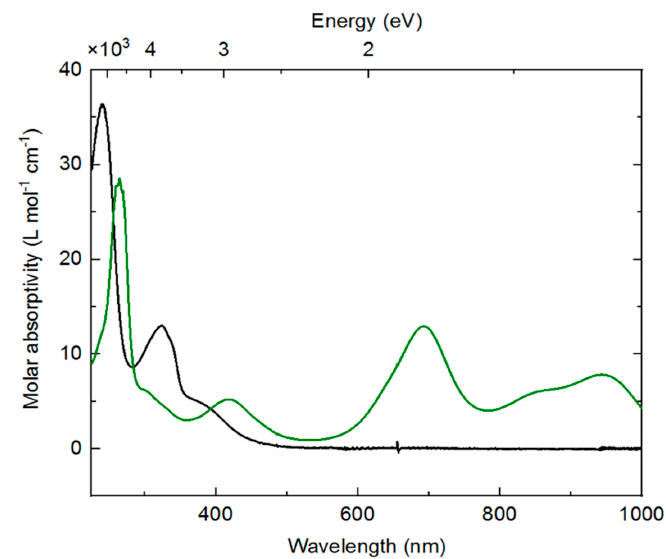
Figure 4. Electronic absorption spectra of 3 (black line) and 4 (green line). Conditions: [ 3 ] ≈ [ 4 ] ≈ 10 − 5 ; solvent: tetrahydrofuran.